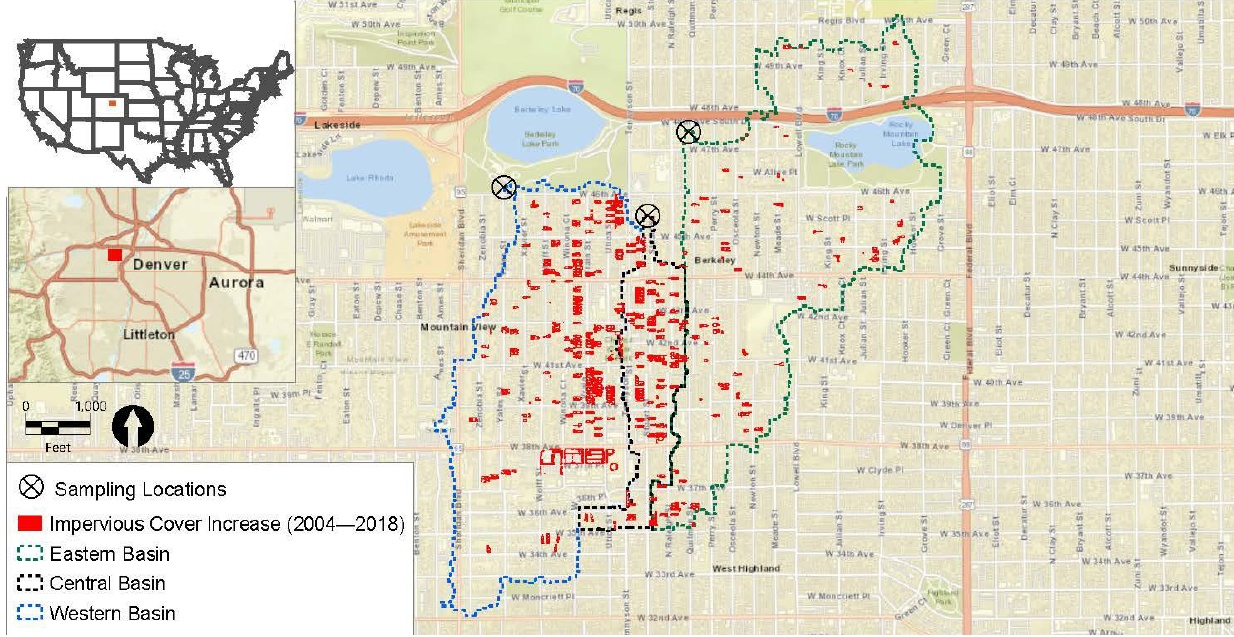
Figure 2. Map of delineated sampling basins within Denver (approximately 39°46’36.17” N, 105°2’21.44” W), showing locations of increased impervious coverage between 2004 and 2018 (increased impervious coverage shown in red).